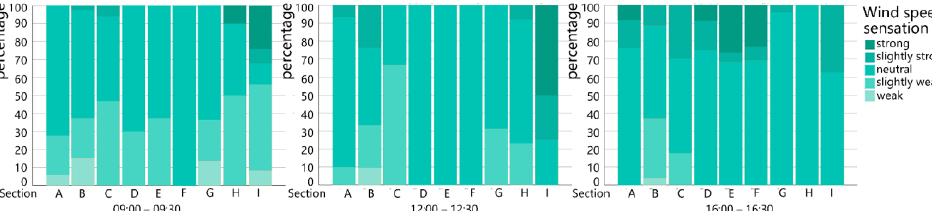
Figure A5. Wind speed sensation votes of the three time periods on 11 September.